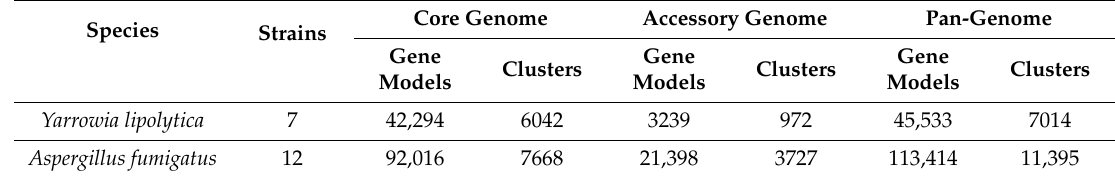
Table 2. Pan-genomes of Yarrowia lipolytica and Aspergillus fumigatus . Refer to Table S1 for further information including strain assembly statistics, BUSCO completeness and links to relevant literature. Core Genome Accessory Genome Pan-Genome Species Strains Gene Gene Gene Clusters Clusters Models Models Models